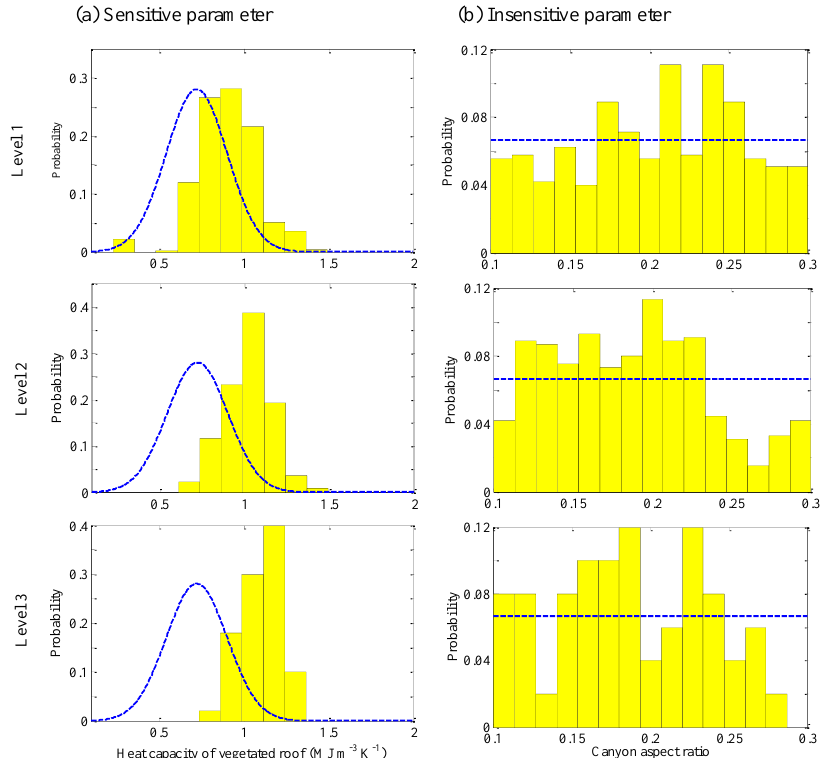
Figure 7. Histogram of conditional samples at different conditional levels for (a) a sensitive parameter and (b) an insensitive parameter for a typical simulation with f veg = 1.0 and critical q as model